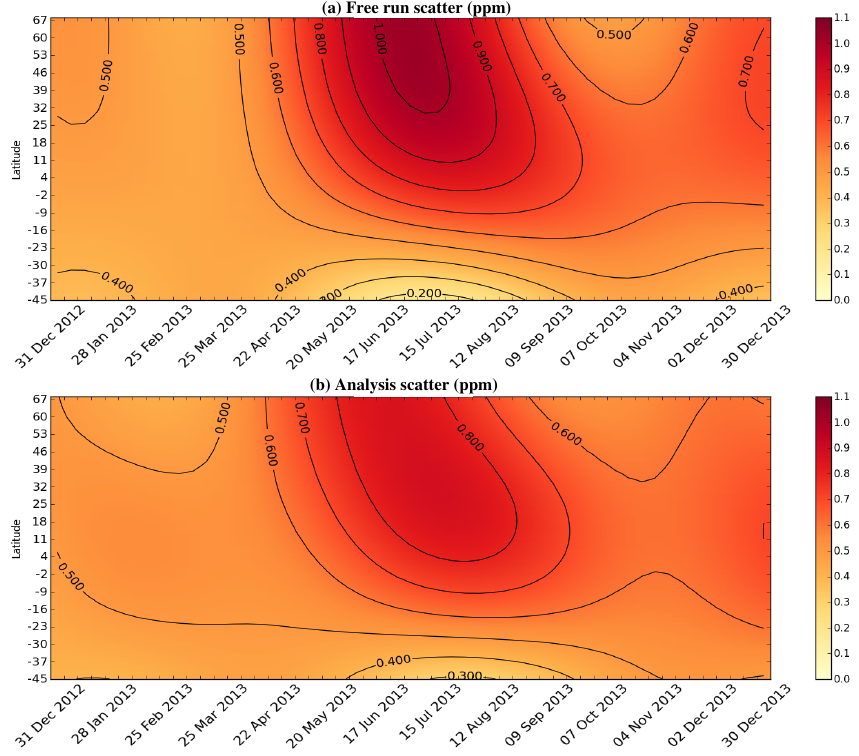
Figure 3. Same as Fig. 2 but for the standard deviation, with yellow/red for low/high